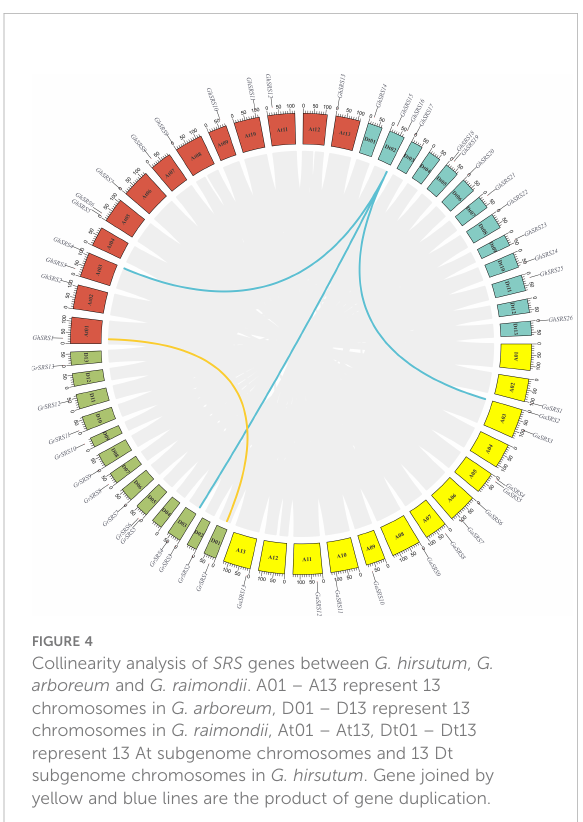
FIGURE 4 Collinearity analysis of SRS genes between G. hirsutum , G. arboreum and G. raimondii . A01 – A13 represent 13 chromosomes in G. arboreum , D01 – D13 represent 13 chromosomes in G. raimondii , At01 – At13, Dt01 – Dt13 represent 13 At subgenome chromosomes and 13 Dt subgenome chromosomes in G. hirsutum . Gene joined by yellow and blue lines are the product of gene